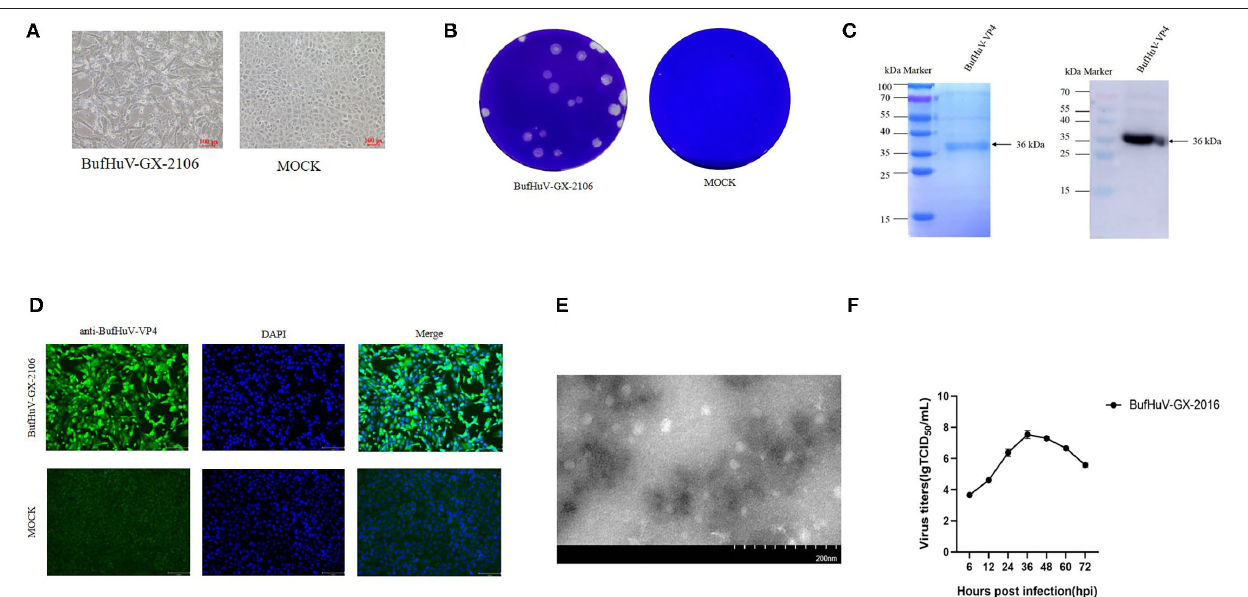
FIGURE 1 | Isolation and identification of the BufHuV-GX-2106 strain in MDBK cells. (A) CPE in MDBK cells infected with the BufHuV-GX-2106 strain. Mock infected and virus infected MDBK cells were observed at 36 hpi. Photomicrographs were taken at a magnification of 20X. (B) Plaque morphology of the BufHuV-GX-2106 strain on MDBK cells. Monolayers of MDBK cells were inoculated with BufHuV-GX-2106 which were then overlaid with 1% agarose and stained with crystal violet at 48 hpi. (C) Analysis of expression of the purified BufHuV-VP4 by SDS-PAGE and western blot analysis of expressed recombinant BufHuV-VP4 showing reactivity with horseradish peroxidase-conjugated anti-His-tag monoclonal antibody. (D) IFA analysis of the VP4 protein expression was conducted in BHK-21 cells. The virus infected cells were fixed and stained using an anti-buffalo hunnivirus-VP4 PcAb and goat anti-rabbit IgG H&L (green). The cell nuclei were visualized by DAPI (blue) staining. (E) Electron microscopic examination of BufHuV-GX-2106 particles. MDBK cells were infected with BufHuV-GX-2106, and the precipitated viruses were processed for electron microscopy. (F) The growth of BufHuV-GX-2106 in cultured MDBK cells. At different times post infection, the cell supernatants were collected and the virus titers were determined as TCID 50 values. The results represented are the means of three independent